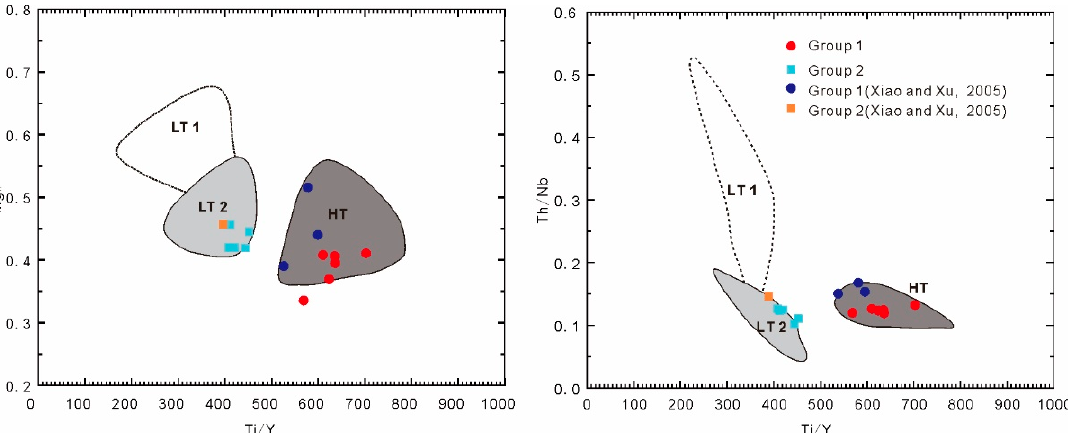
Figure 5. Diagrams showing the variation of Mg# and Th/Nb against Ti/Y for the Emeishan basalts. Shaded areas indicate the domains of the Emeishan basalts from the Binchuan area [20,44].